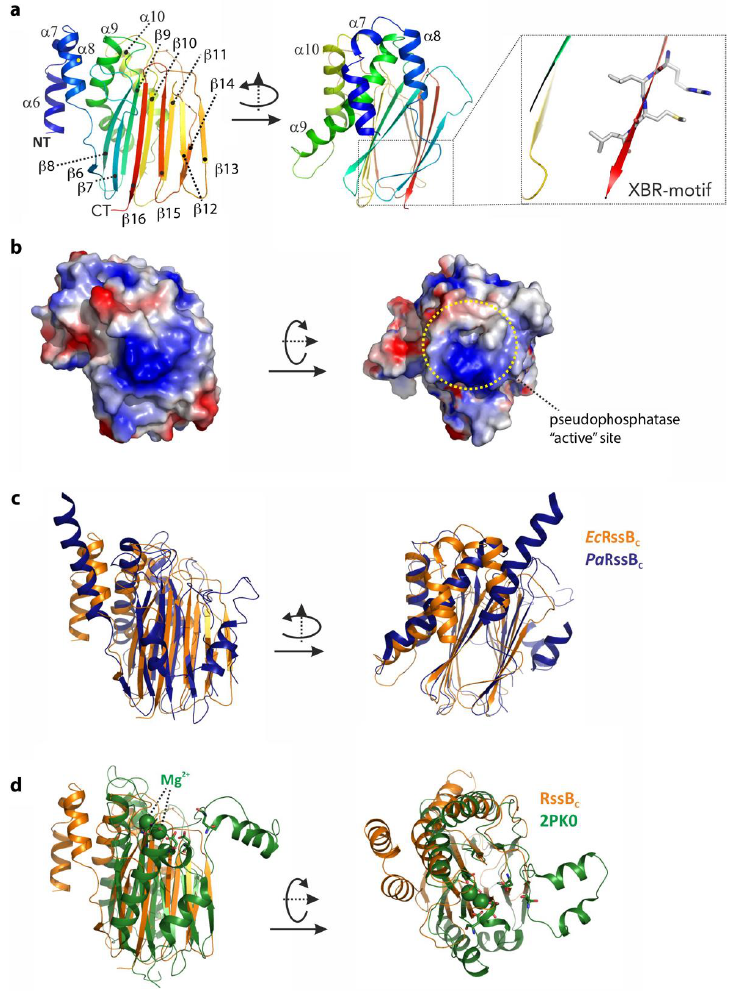
Figure 3. The structure of the C-terminal domain of RssB (RssB C ) and superposition with close structural homologs. ( a ) The structure of the C-terminal domain of RssB is shown in cartoon representation from two perspectives related by a rotation of 90 degrees around the Y -axis. The structure is a mixed α / β -structure formed by α -helices α 6– α 10 and β -sheets β 6– β 16. The C-terminal XBR-motif is shown (boxed). ( b ) Surface representation of the C-terminal domain with the electrostatic potentials marked. The left panel shows the same orientation used in ( a ), the right orientation was rotated by 90 degrees around the x -axis. The putative active site is marked. ( c ) Structure comparison of RssB C shown in the same orientation as in ( a ) with the C-terminal domain of RssB from P. aeruginosa displayed in dark blue. ( d ) Superposition of RssB C shown in orange (same orientation as is ( a )) with the serine / threonine phosphatase structure of S. agalacticae shown in green (PDB-entry 2PK0). Magnesium atoms known to be important for function of the phosphatase are marked in ball representation and active site residues are shown in stick